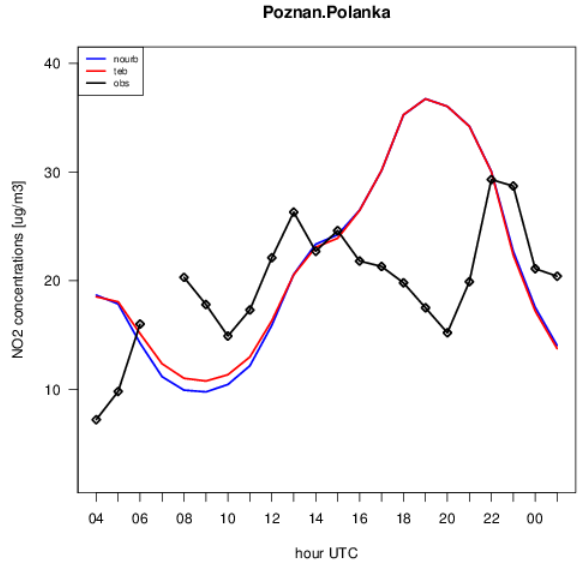
concentrations with observations from station 2